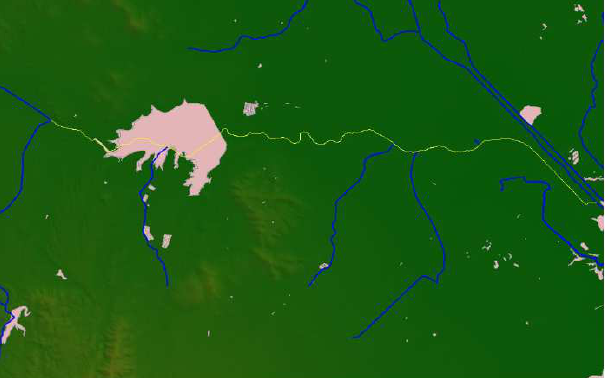
Fig. 3 . GIS elements framing of the case